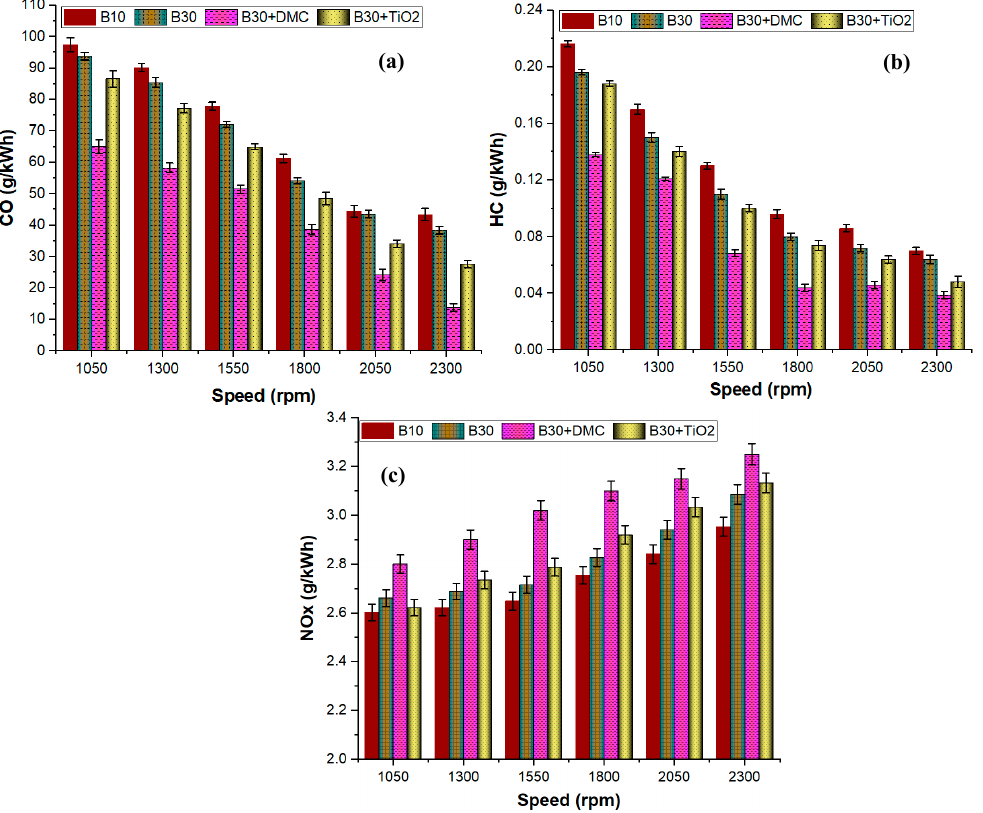
Figure 6. Variation of engine exhaust emissions: ( a ) CO, ( b ) HC, and ( c ) NOx with respect to speed at 100% engine load.